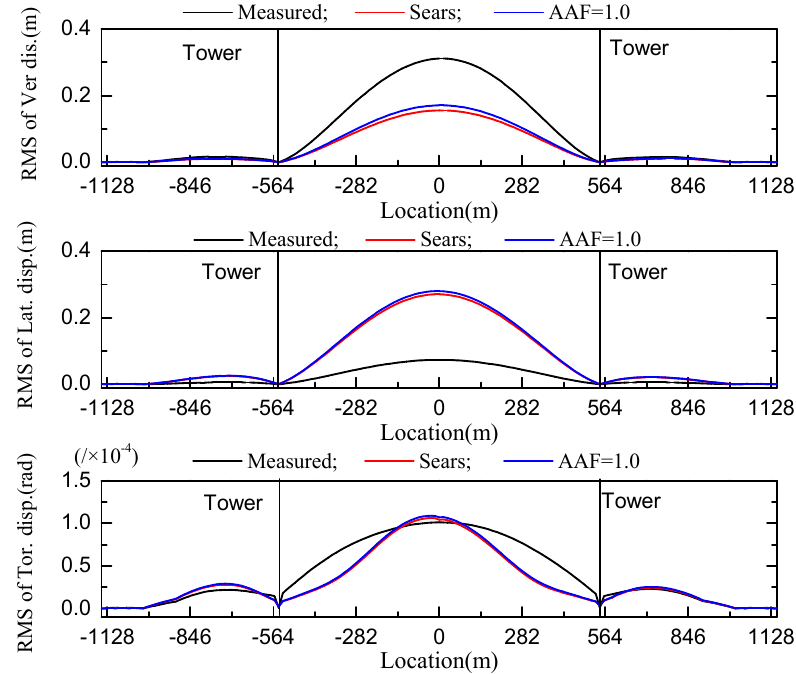
Figure 19. RMS of the truss girder displacements at the construction stage under different AAFs. Table 8. RMS maximum value of mid-span in the service and construction stages. Service stage Direction